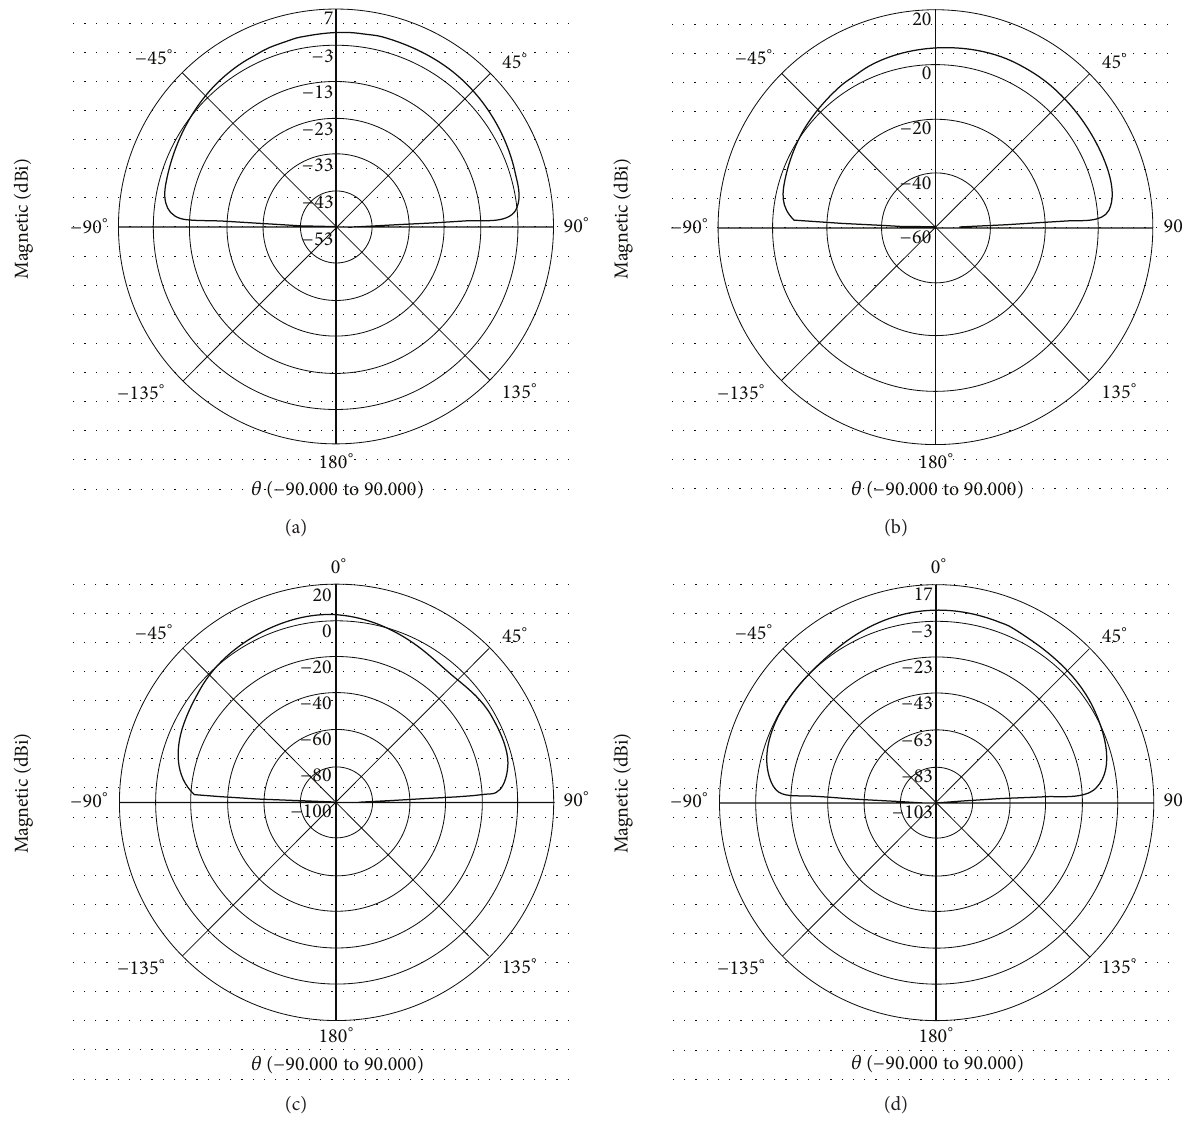
Figure 11: Simulated two-dimensional (2D) radiation gain patterns of the proposed antenna composed of four unit cells in elevation plane ( Φ = 0 ∘ ) and at operation frequencies: (a) at 4.3GHz, (b) at 7GHz, (c) at 17GHz, (d) at